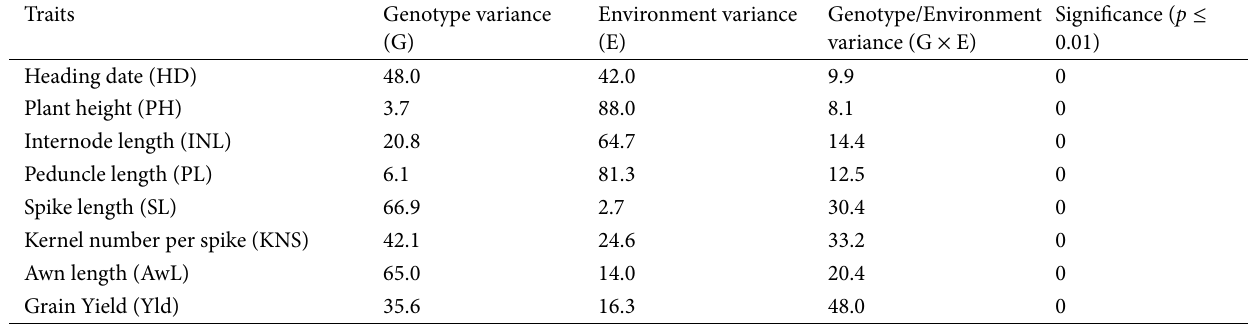
Table 5 Analysis of variance across three cropping